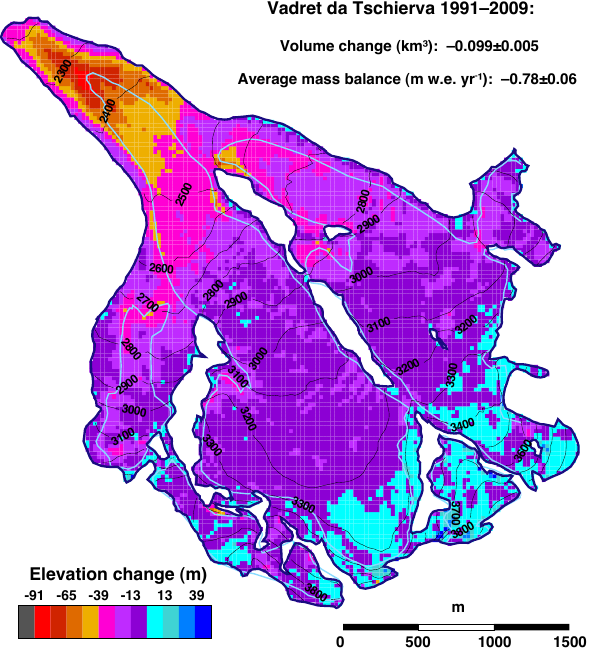
Figure 2. Spatial distribution of elevation changes for Vadret da Tschierva 1991–2009 within the digital glacier outlines from both the 1973 (dark blue) and the 2010 (light blue) inventories.